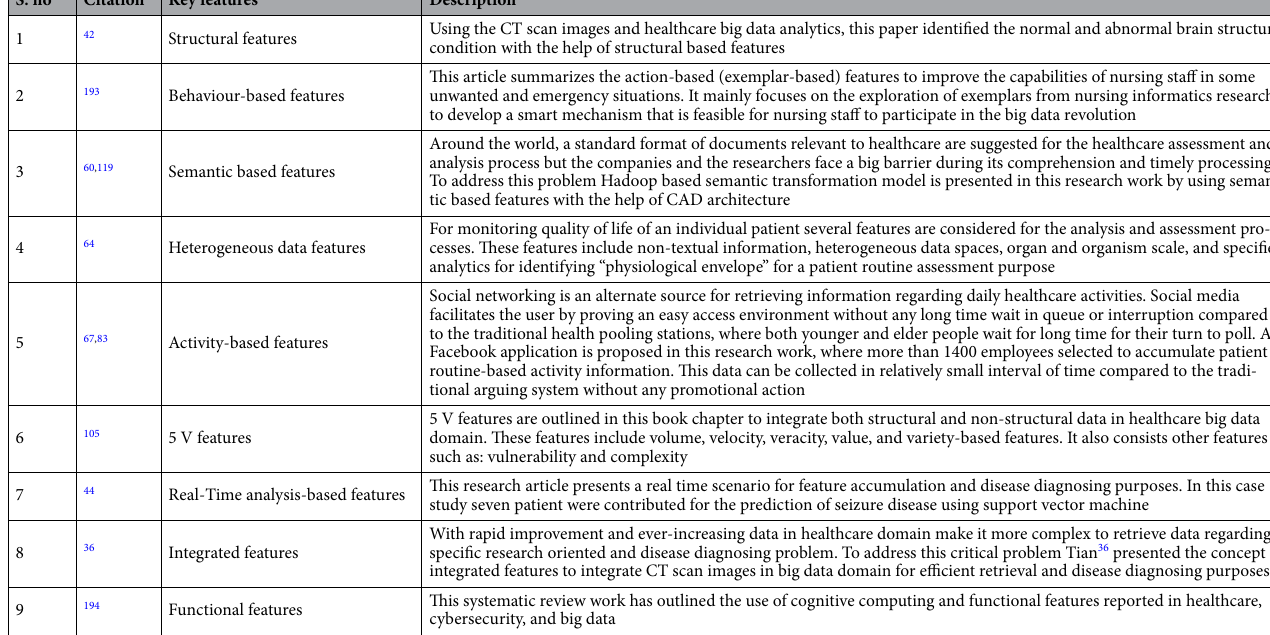
Table 7. List of key features used for data integration